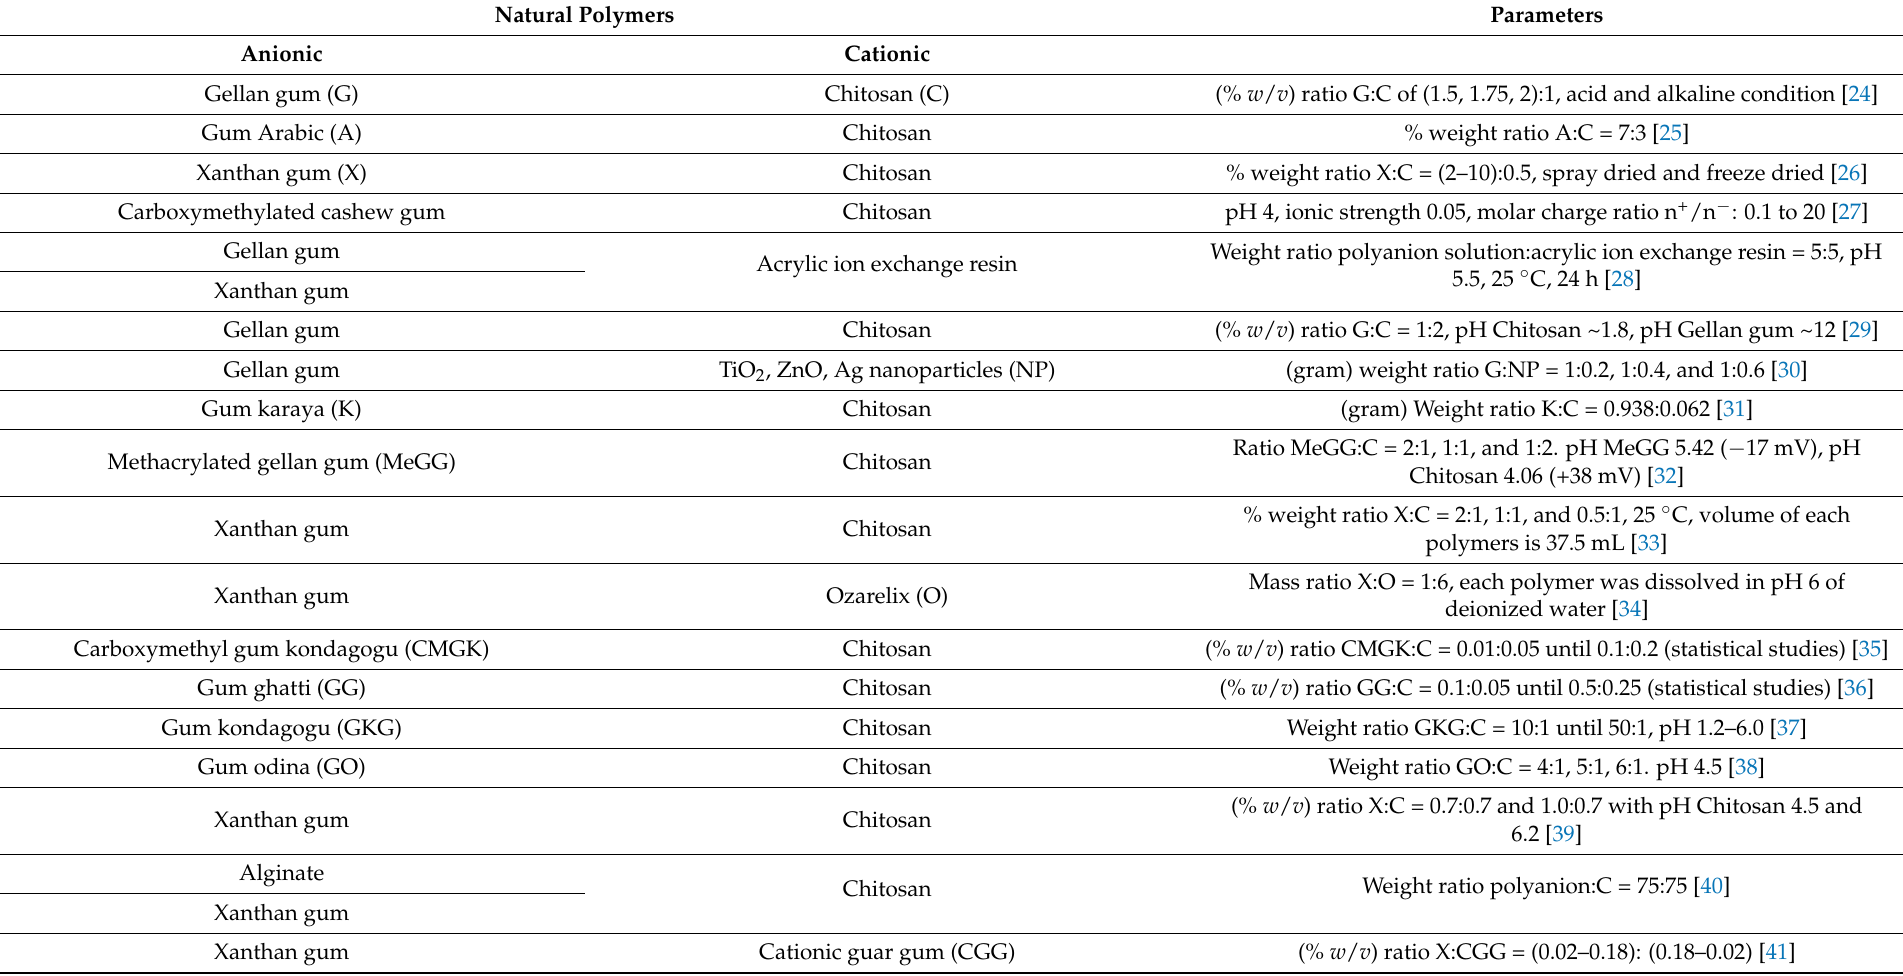
Table 1. The parameters used in the preparation of gum-based